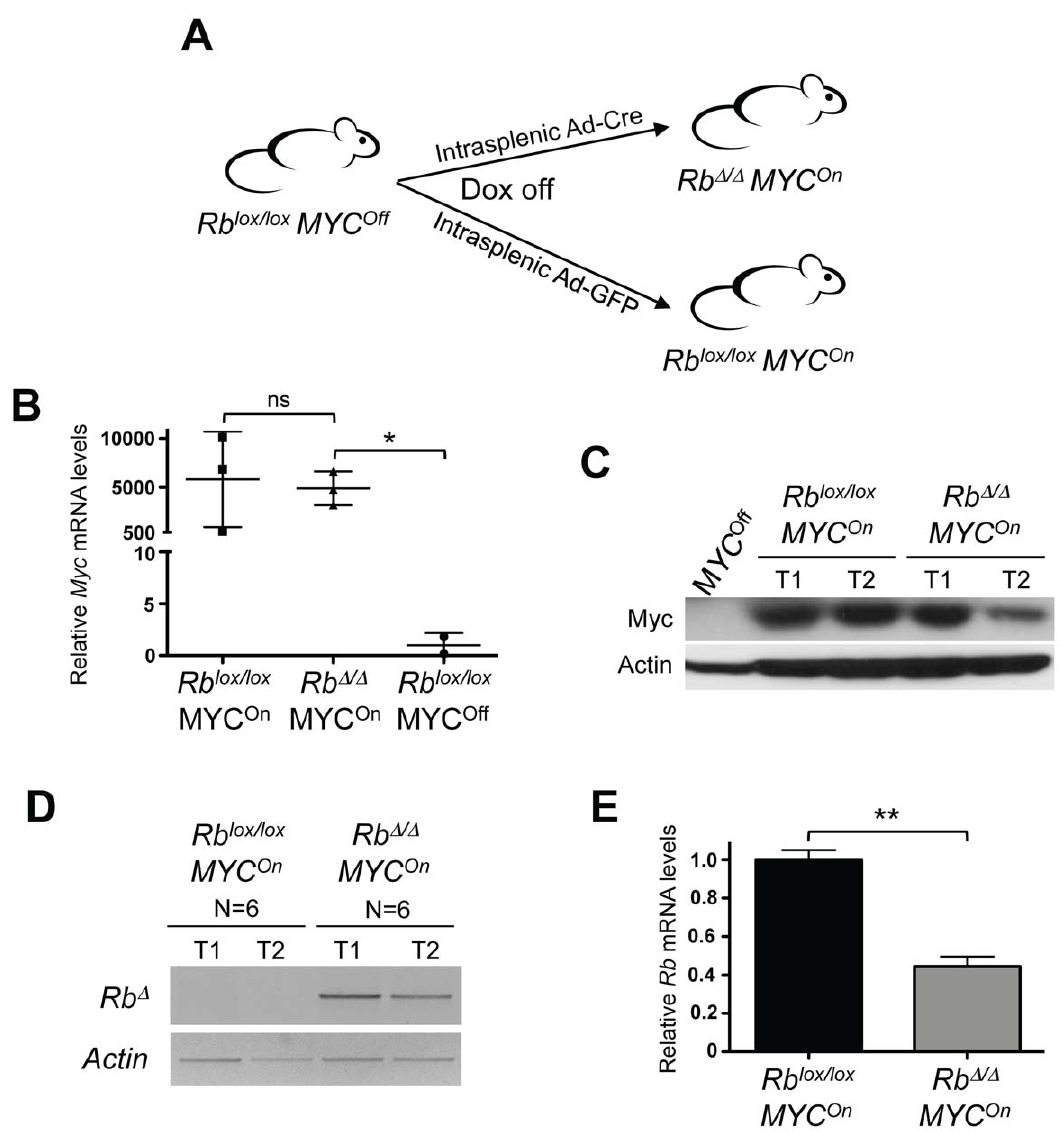
Figure 1. MYC activation and Rb deletion drive HCC development in the liver of adult mice. A. Strategy to produce MYC and MYC/Rb mutant tumors using Rb lox/lox and TRE- MYC LAP- tTA mice. MYC is activated in the liver by the removal of doxycycline from the drinking water while Rb is specifically deleted in the liver by splenic injection of Ad-Cre. Ad-GFP is used as a control. B. RT-qPCR analysis of MYC RNA levels in control livers ( Rb lox/lox MYC Off , n=2) and in MYC and MYC/Rb mutant tumors (n=3). C. Immunoblot analysis of MYC protein levels in control livers ( MYC Off ) and in MYC and MYC/Rb mutant tumors (two independent tumors each, T1 and T2). Actin serves as a loading control. D. Genomic PCR analysis for the deleted allele of Rb ( Rb D ) using DNA from MYC and MYC/Rb mutant tumors. Actin serves as a positive PCR control. E. RT-qPCR analysis of Rb RNA levels in MYC (black, n=3) and MYC/Rb (grey, n=3) mutant tumors.